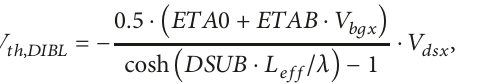
is built-in potential, 𝜑 bi is effective channel length, and DVT0 , eff